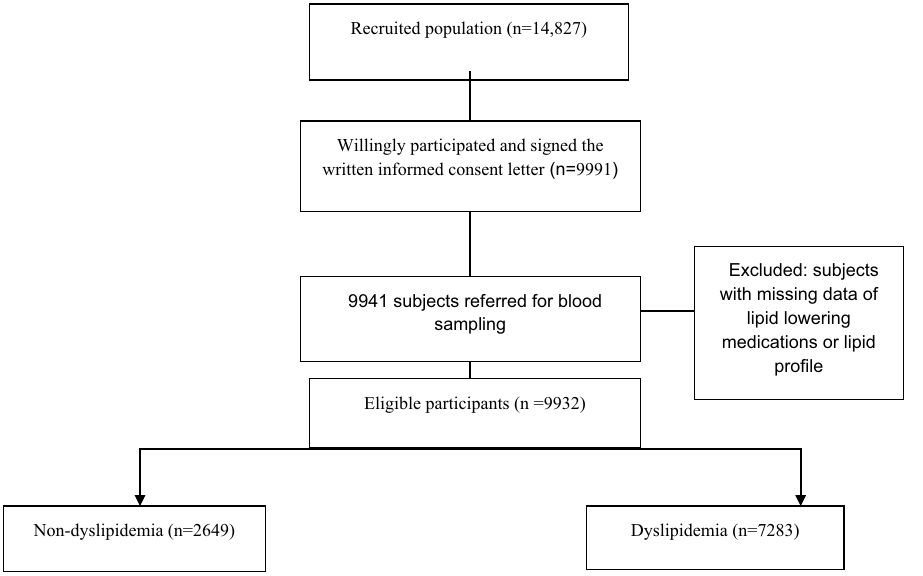
Figure 1. Flowchart of the study design of lipid profile in Rafsanjan cohort